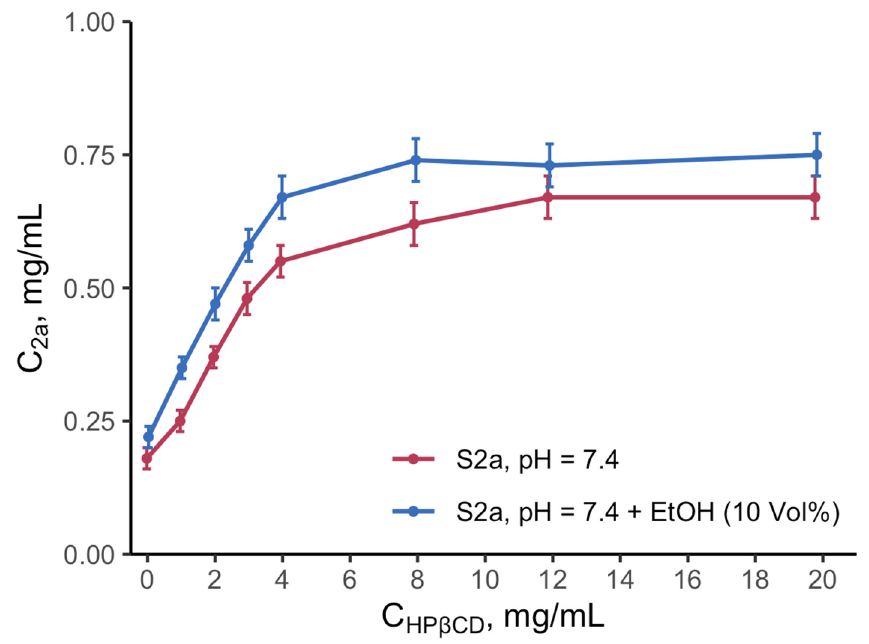
Figure 6. Phase-solubility profiles for HP β CD- 2a complex in sodium phosphate buffer (pH 7.4) (red curve) and in sodium phosphate buffer (pH 7.4) with EtOH (10 vol%) (blue curve), C 2a =1 mg/mL, shake-flask method.